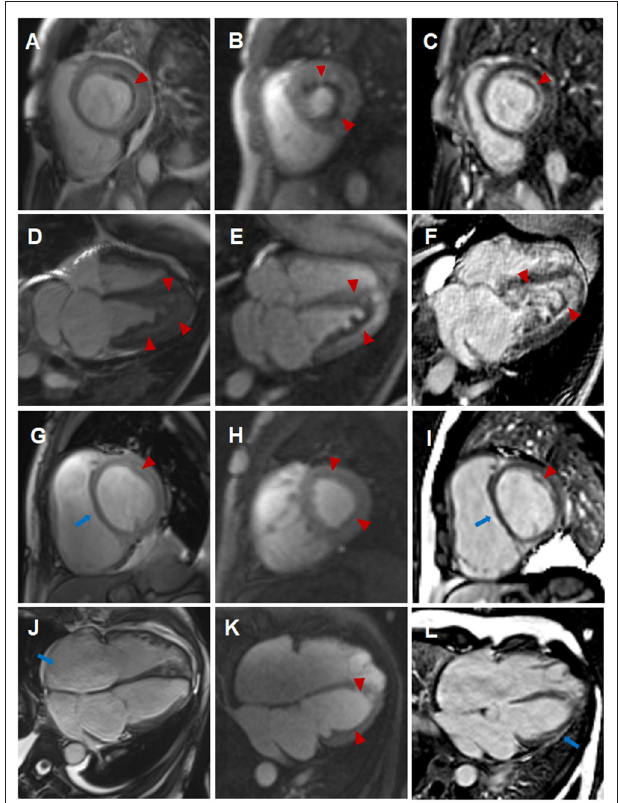
FIGURE 2 | Comparison of cardiovascular involvement detected by CMR during two separate hospitalizations (A–F) CMR findings during the initial hospitalization ( A–C , short-axis view; D–F , four-chamber view). Distinct high-signal-intensity plane separating the thrombus from underlying myocardium on end-diastolic cine images ( A,D , triangular arrows), endocardial surface hypoperfusion zone on perfusion images ( B,E , triangular arrows) and endocardial enhancement and overlying non-enhancing thrombus on LGE images ( C,F , triangular arrows). (G–L) CMR findings during the subsequent hospitalization ( G–I , short-axis view; J–L , four-chamber view). Enlargement of right atrium and right ventricle, flat ventricular septum ( G,J , long arrows) and significantly reduced high-signal-intensity plane and thrombus ( G,J , triangular arrows) on cine images, significantly reduced endocardial surface hypoperfusion zone on perfusion images ( H,K , triangular arrows) and significantly thinning endocardial enhancement and overlying thrombus ( I,L , triangular arrows), new strip-like LGE in the lateral wall ( L , long arrows) on LGE images, representing replacement